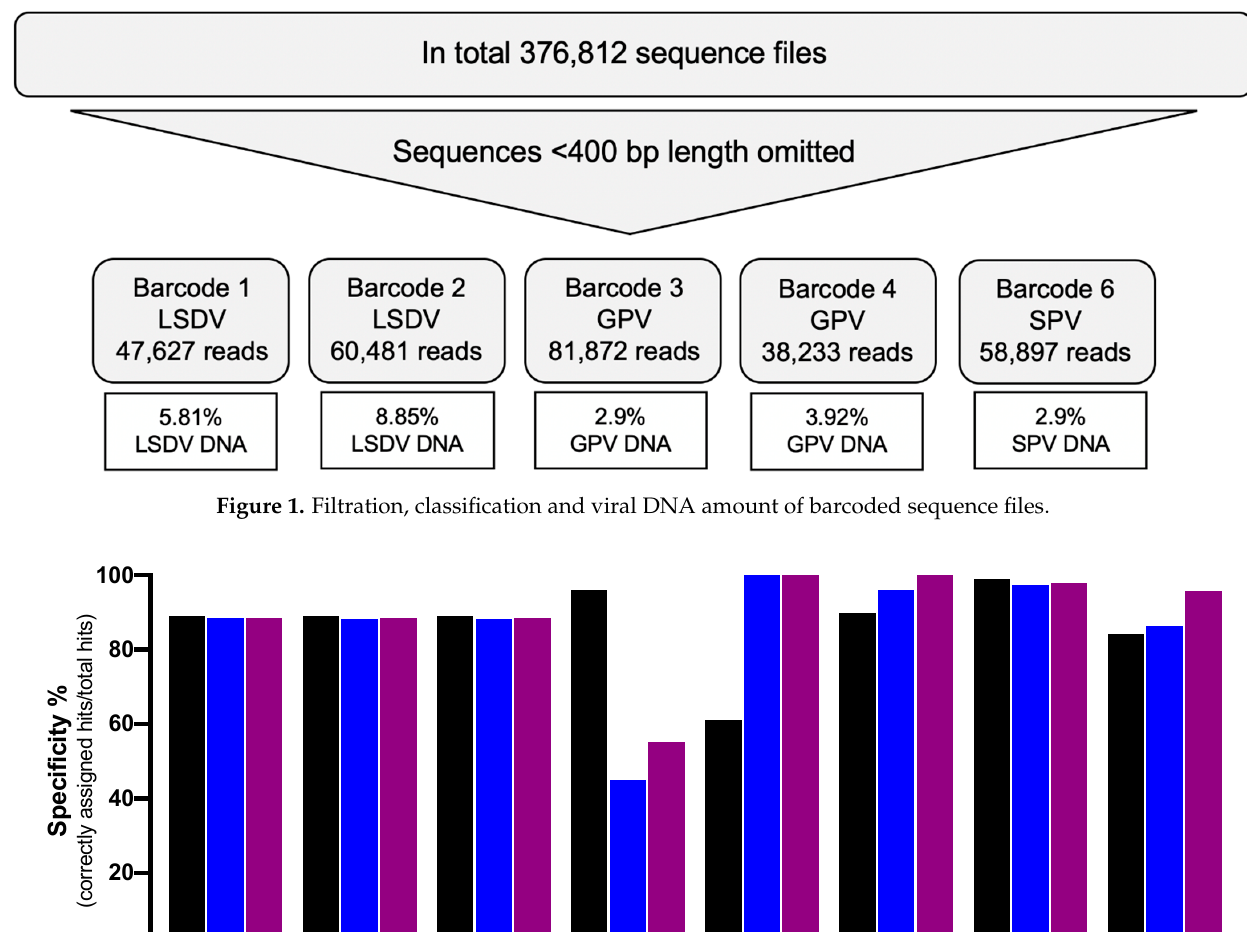
Figure 1. Filtration, classification and viral DNA amount of barcoded sequence files. Offline BLAST specificities of 5, 10 and 15 kbp genome regions, whole genome,